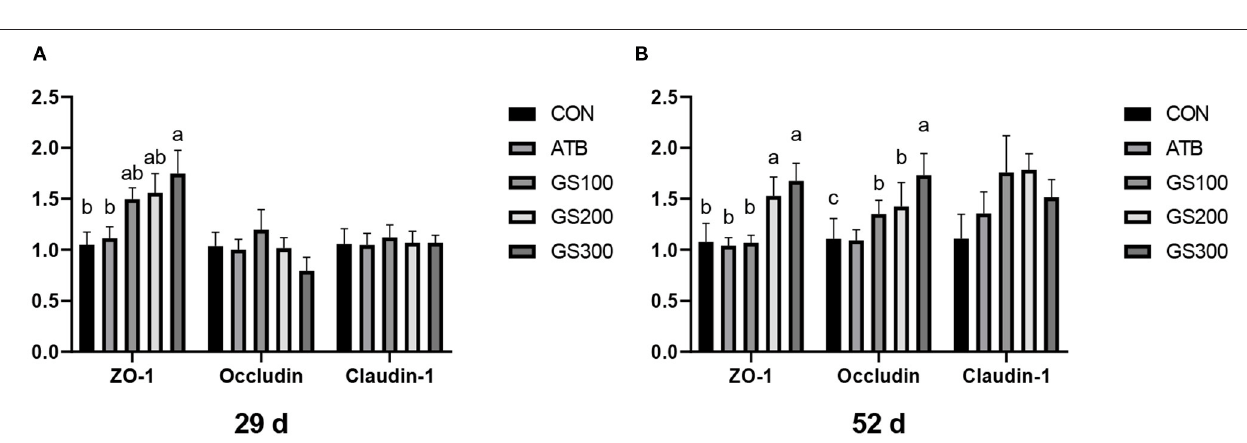
FIGURE 4 | Effects of ginsenoside Rg1 on mRNA levels of key tight junction genes at day 29 (A) and day 52 (B) in broiler chickens ( n = 6). CON, birds fed a basal diet; GS100, birds fed a basal diet supplemented with 100 mg/kg ginsenoside Rg1; GS200, birds fed a basal diet supplemented with 200 mg/kg ginsenoside Rg1; GS300, birds fed a basal diet supplemented with 300 mg/kg ginsenoside Rg1; ATB, a basal diet supplemented with 300 mg/kg chlortetracycline. Data were shown as means ± standard deviations. Mean value without the common letter on the data bar in each figure indicated that the difference was significant ( P < 0.05).